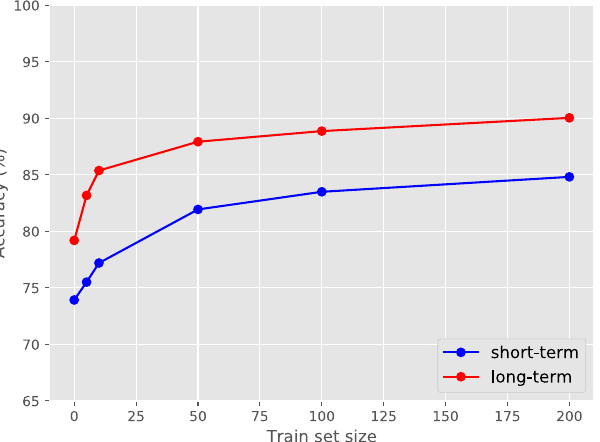
Figure 5. Finetune on a new medical center. Fine-tuning both the short- and long-term baseline models, which were initially trained on a dataset excluding videos from medical center 1, on an increasing number of videos from medical center 1. Log-scale version is available in Supplementary Fig.